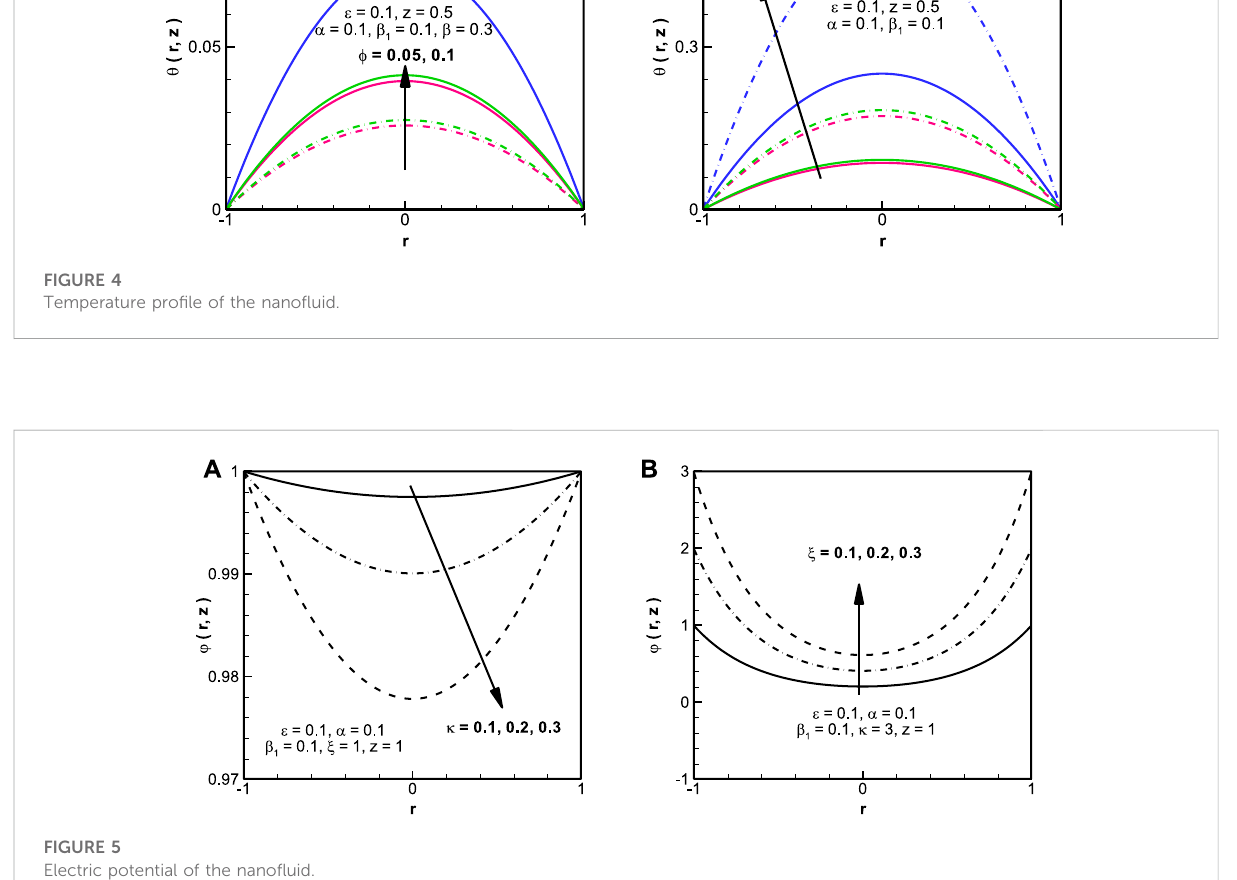
FIGURE 5 Electric potential of the nano fl